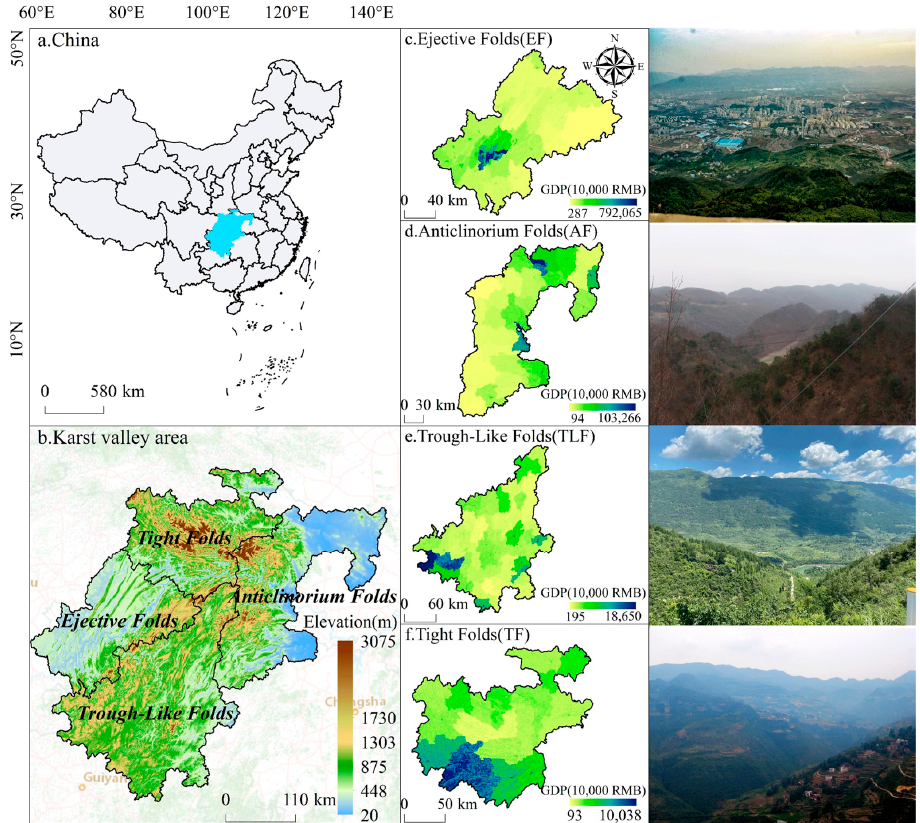
Figure 1. The study area (c-f represents the spatial distribution of GDP under the 1 km × 1 km raster of the karst trough valley landform for four types of ejective folds (EF), anticlinorium folds (AF), trough-like folds (TLF), and tight folds (TF), respectively).